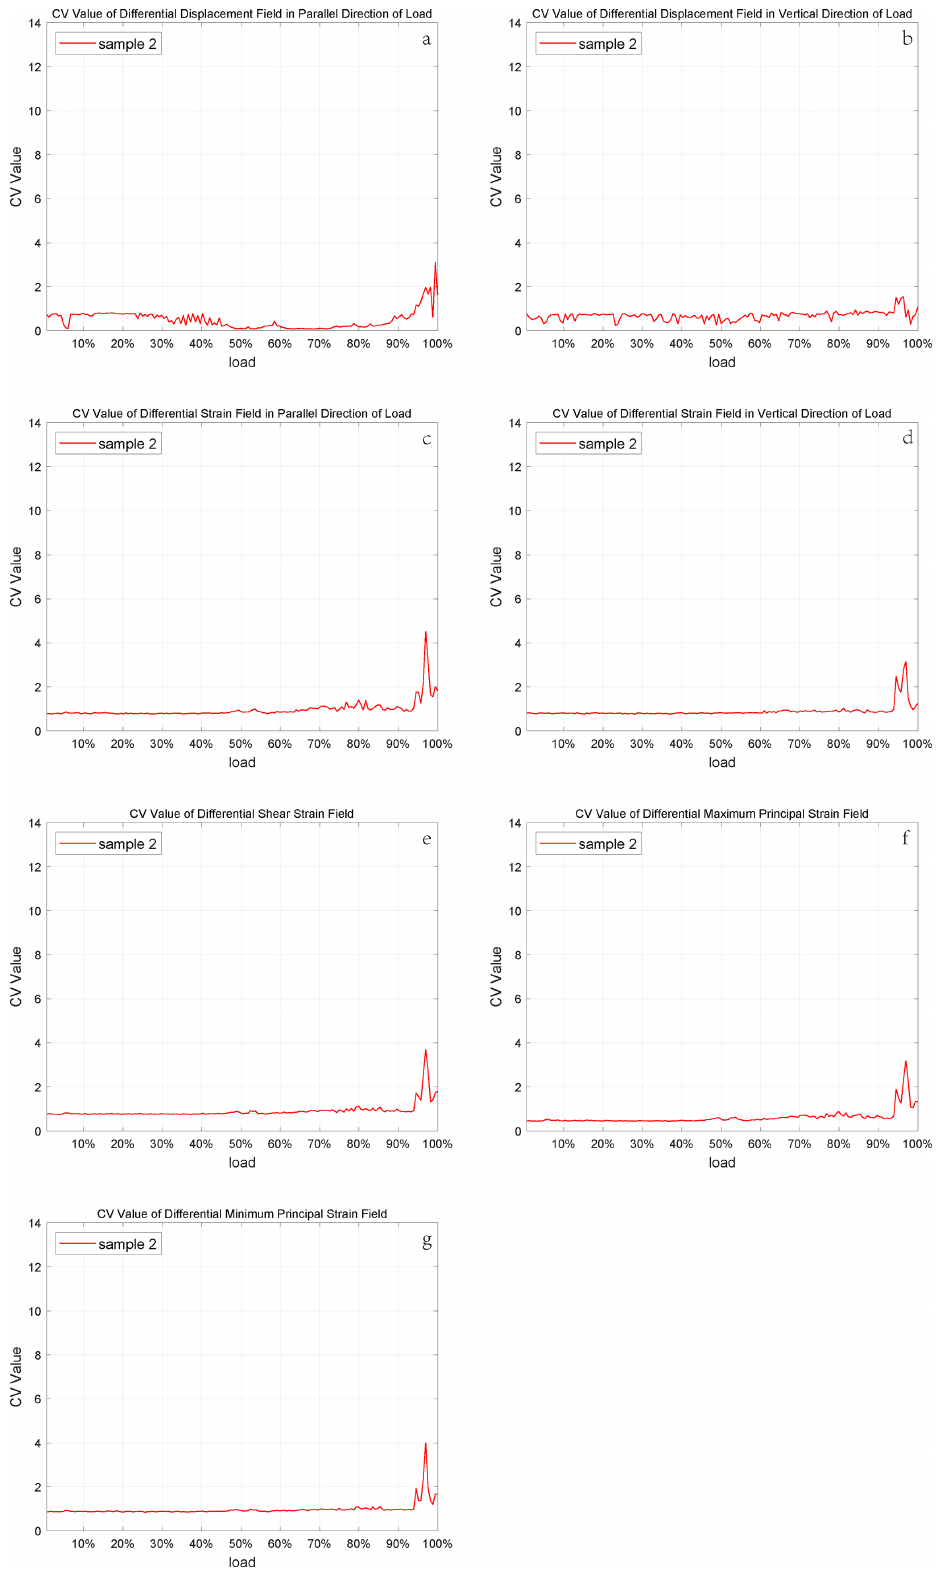
Figure A2. CV images of sample